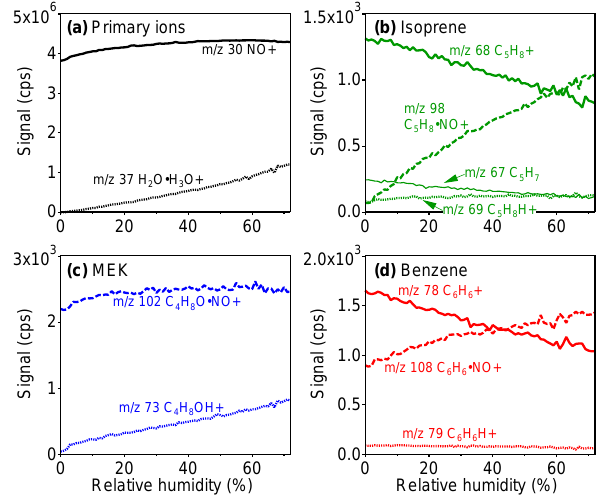
Figure 7. Humidity dependence of primary ions and selected VOCs. (a) NO + and water clusters; (b) isoprene; (c) methyl ethyl ketone (MEK); (d)